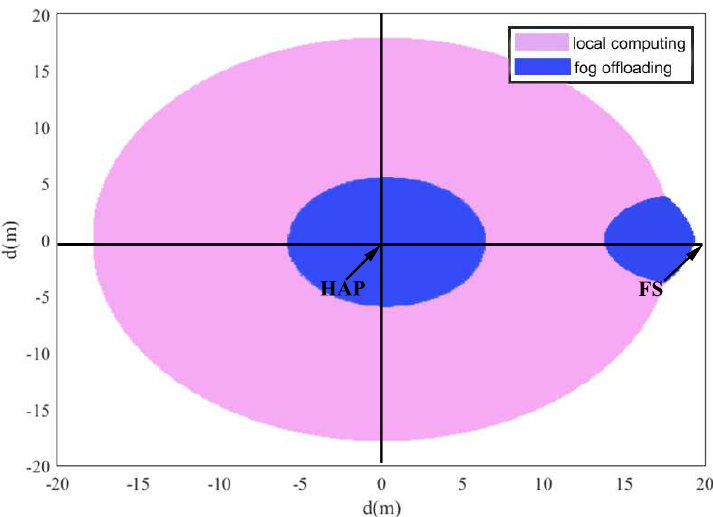
Figure 6. The mode selection deployment.